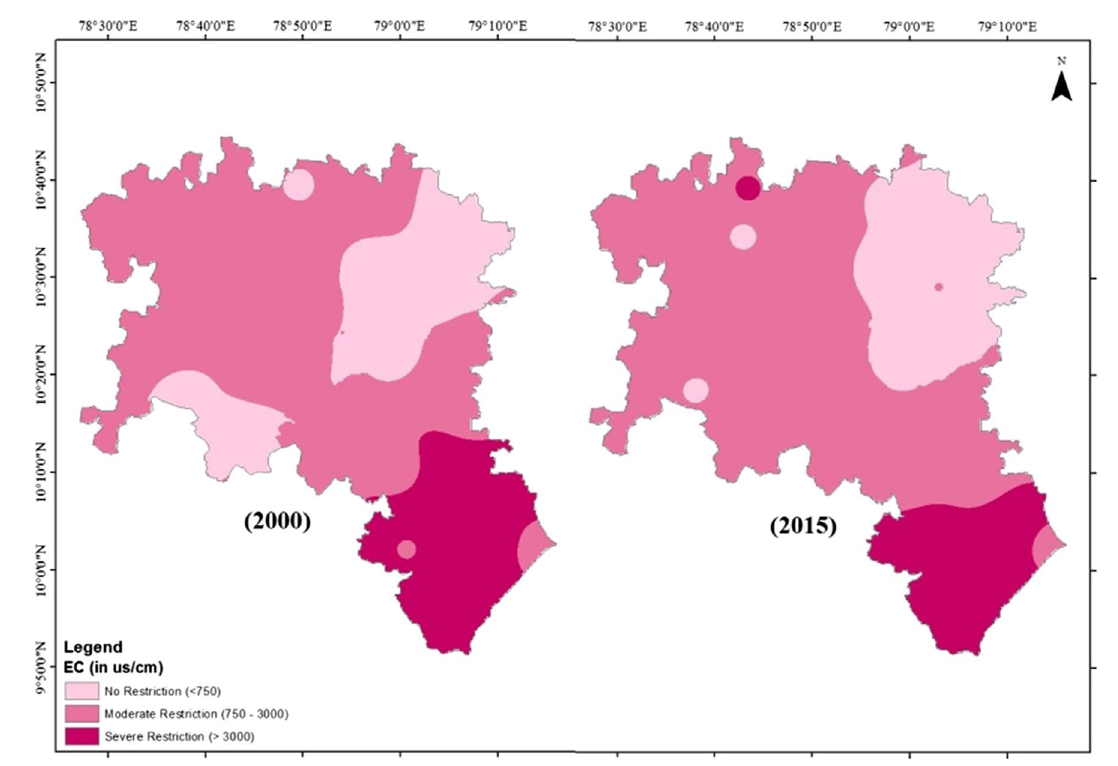
Fig. 2 Spatial distribution of electrical conductivity (2000 and